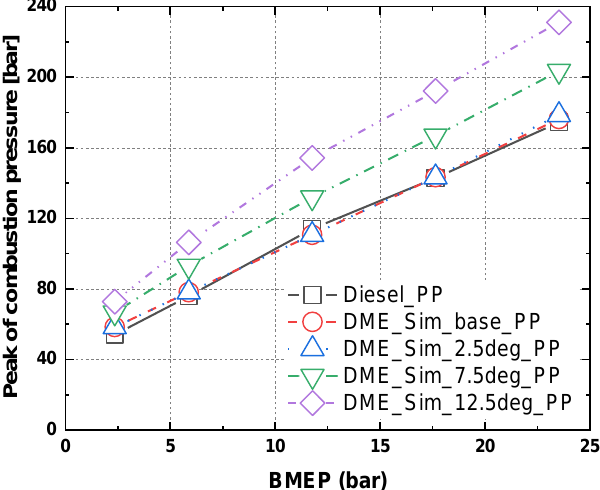
Figure 4. Characteristics of the pressure peaks versus start of injection timing for marine diesel fuel and DME fuel.